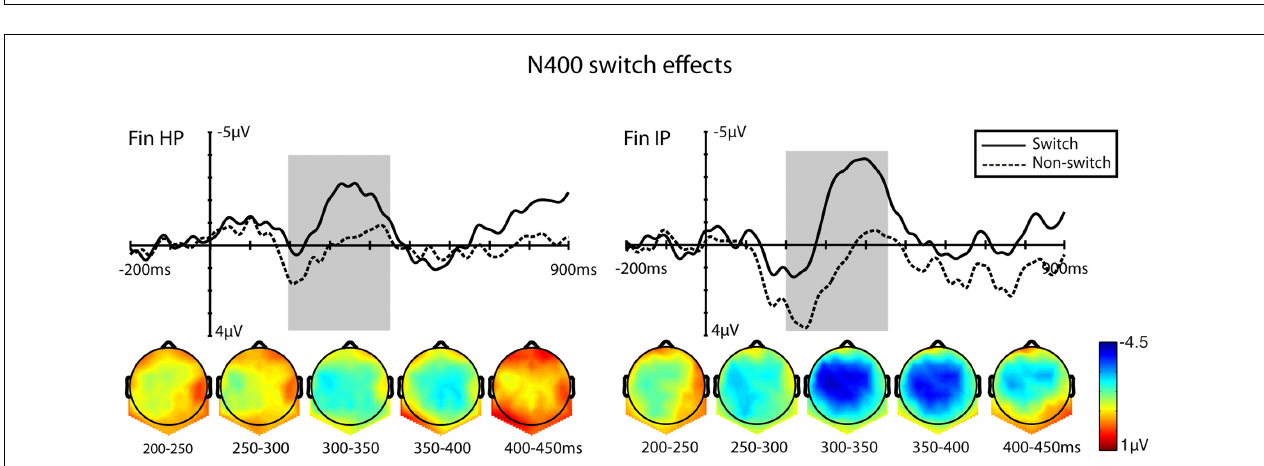
FIGURE 2 | Grand-average waveforms taken from a ROI consisting of a set of nine centro-parietal electrodes. Each of the four conditions is plotted for the two L2 learner groups. The shaded region shows the semantic N400 effect that was found during switched items (the difference between congruent and incongruent words). Accompanying scalp maps were obtained for the 350–500 ms time windows for the averaged values of difference waves (language-switched incongruent minus language-switched congruent). The 200 ms baseline is plotted, and time 0 marks the onset of the target word.